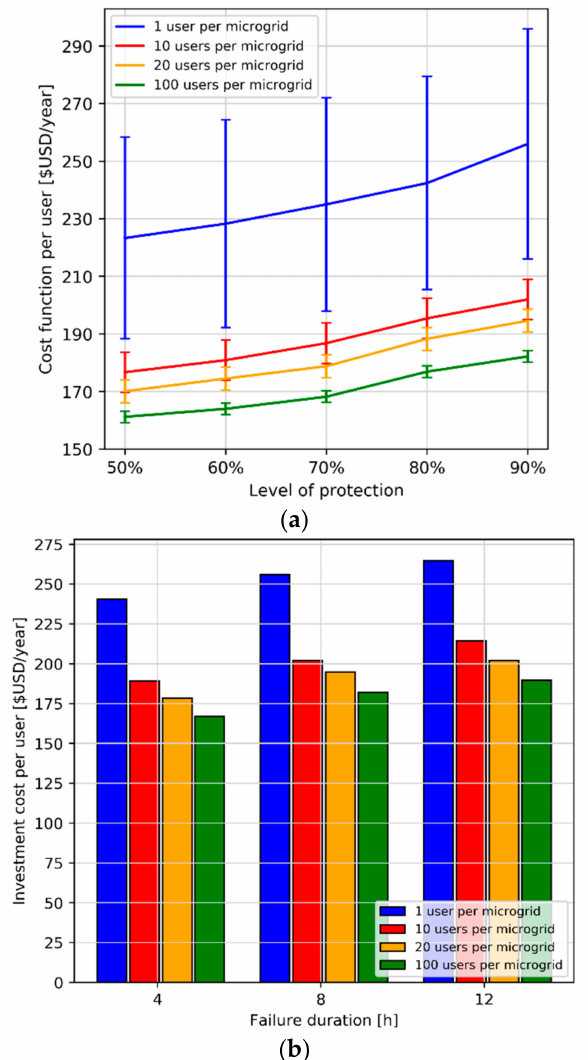
Figure 10. Investment cost per household as a function of ( a ) protection level for faults of 8 h duration and ( b ) duration of faults with 90% protection level (Case